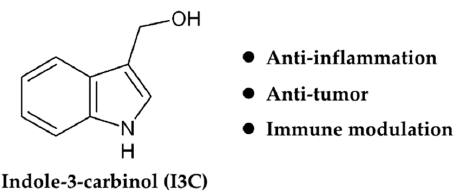
Figure 1. The chemical structure and pharmacological activities of indole-3-carbinol (I3C). Infection-induced inflammation is a common risk factor for certain types of cancer. Cr infection